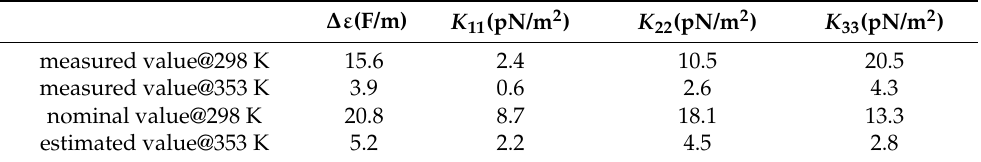
298 K to the measured values at 355 K.